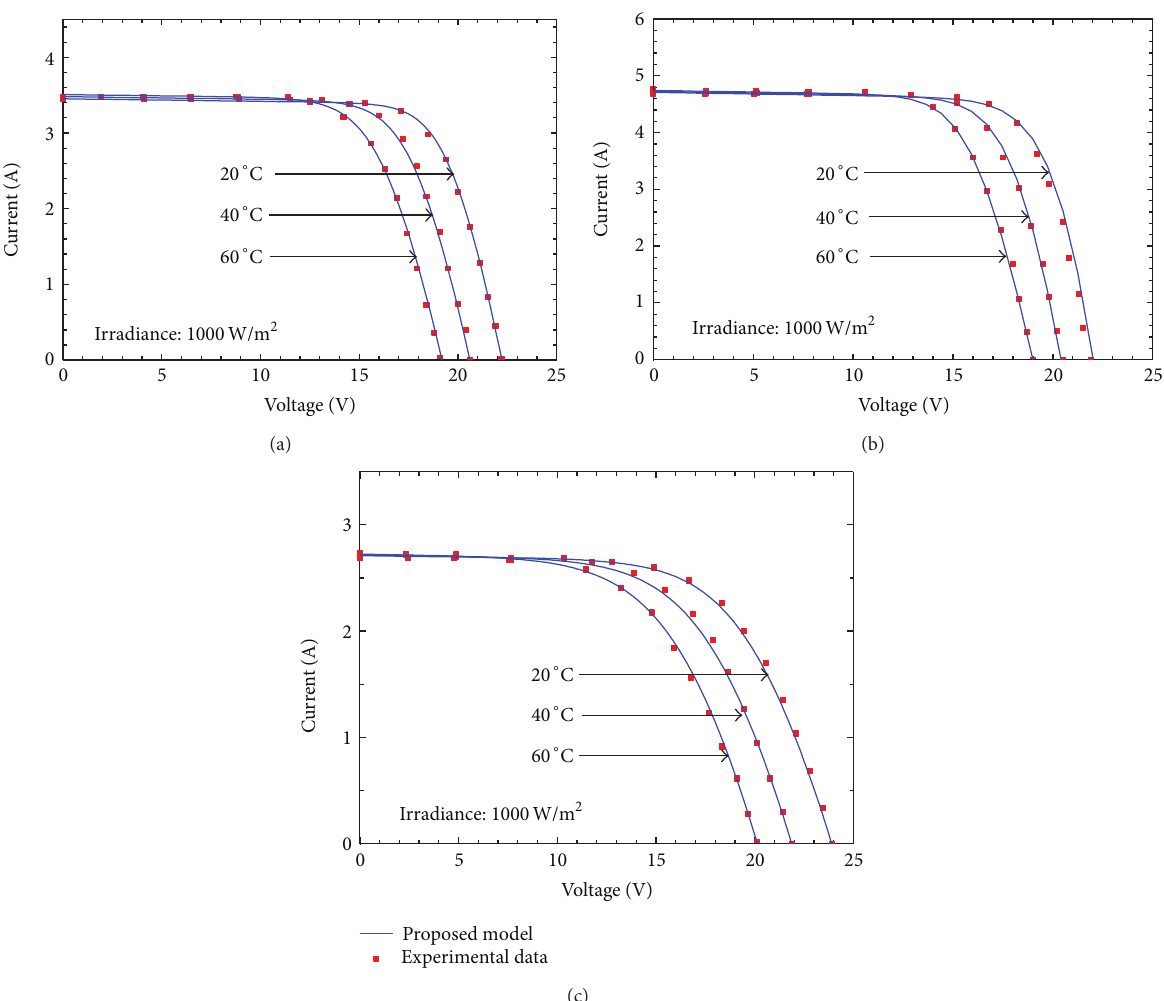
Figure 4: Calculated I - V curves and experimental data of Shell SM55 (a), Shell S75 (b), and Shell ST40 (c) at different temperatures, at 1000W/m 2